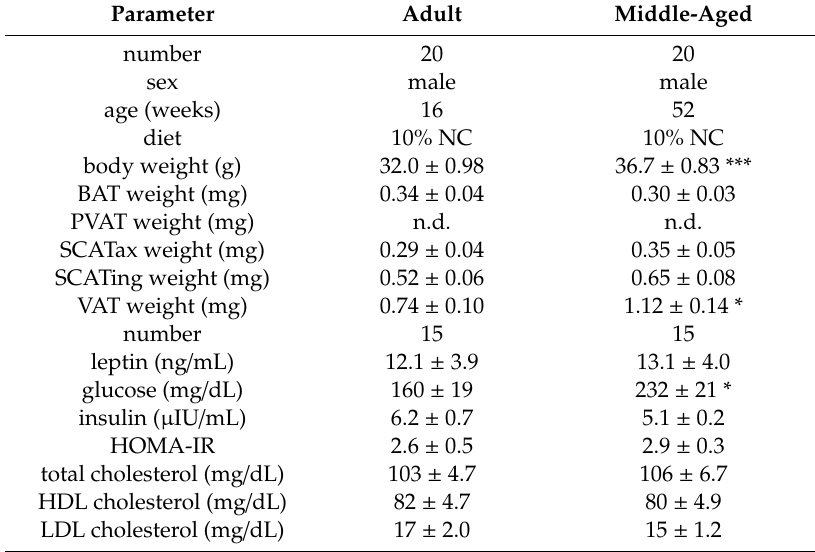
Table 1. Body and adipose tissue weight and fasting serum parameters in adult and middle-aged C57BL / 6J wild-type